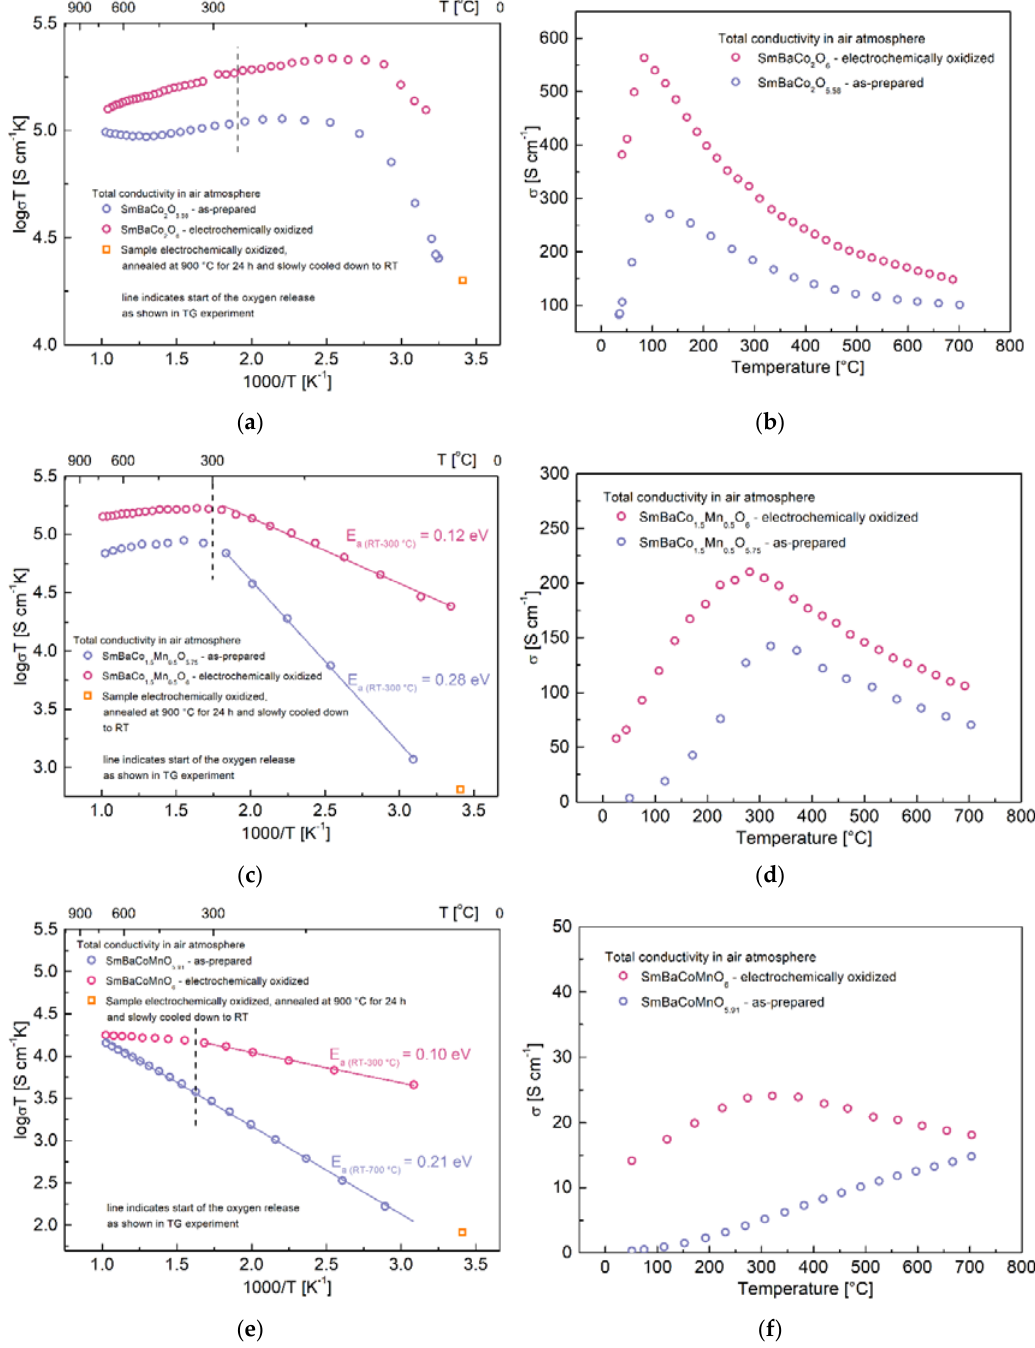
Figure 5. (a) Total electrical conductivity of SmBaCo 2 O 5.58 and SmBaCo 2 O 6 in air as a function of temperature in Arrhenius ‐ type coordinates. ( b ) Total electrical conductivity of SmBaCo 2 O 5.58 and SmBaCo 2 O 6 in air as a function of temperature in the σ‐ T coordinates. ( c ) Total electrical conductivity of SmBaCo 1.5 Mn 0.5 O 5.75 and ( d ) SmBaCo 1.5 Mn 0.5 O 6 in air as a function of temperature in Arrhenius ‐ type and σ‐ T coordinates. ( e ) Total electrical conductivity of SmBaCoMnO 5.91 and ( f ) SmBaCoMnO 6 in air as a function of temperature in Arrhenius ‐ type and σ‐ T coordinates.